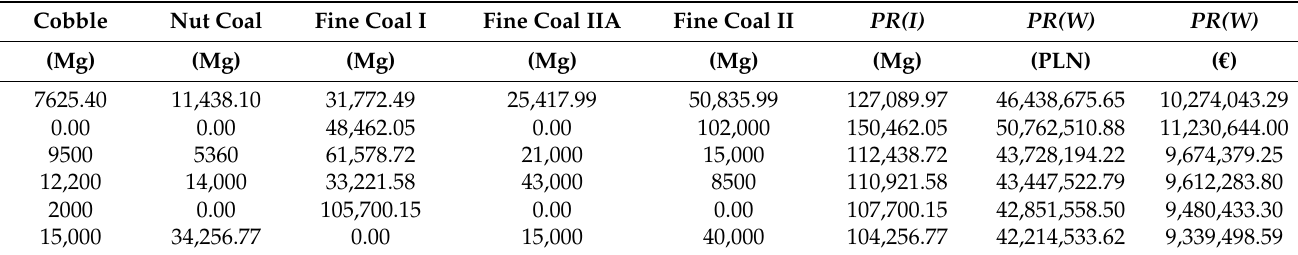
Table 5. Summary of the threshold quantities of the individual coal grades, the total quantity threshold and the ad valorem threshold.